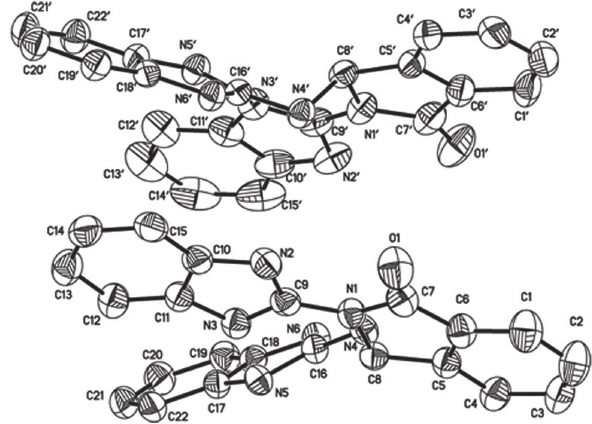
Table 1: Data collection and